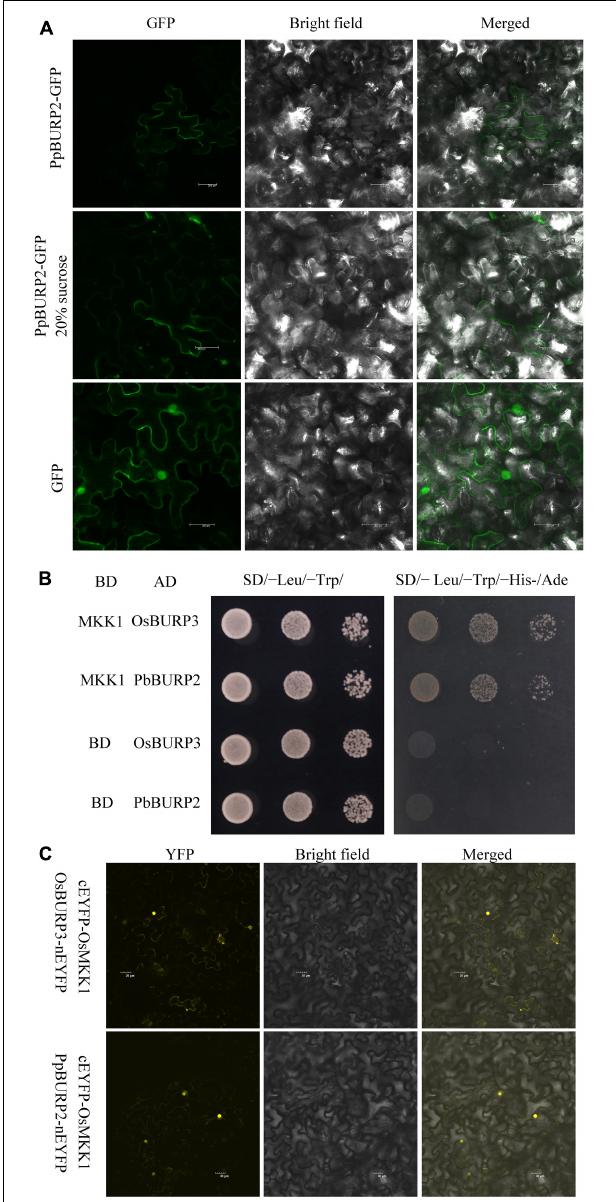
FIGURE 2 | Subcellular Location and protein interaction of PpBURP2. (A) Subcellular location green fluorescent protein (GFP) and PpBURP2-GFP fusion gene under the control of the CaMV35S promoter separately and transiently expressed in the tobacco epidermal cells. Leaves of 35S:PpBURP2-GFP tobacco before (top) and after (middle) treatment with 20% sucrose for plasmolysis, as well as 35S::GFP (bottom). The white bar represents 50 µ M. (B) BURP protein interacting with OsMKK1 using the yeast-two-hybrid method. OsMKK1 gene was cloned into pGBKT7, and OsBURP3 gene and PpBURP2 gene into pGAD-T7, respectively. All of the combinations grew on SD/-Leu/-Trp/, and SD/- Leu/-Trp/-His-/Ade medium at 30 ◦ C for 3–5 days. (C) Bimolecular fluorescence complementation (BiFC) assays in tobacco leaves indicated that the OsMKK1 interacted with PpBURP2 and OsBURP3 in vivo . The OsMKK1 gene was cloned into cEYFP vector and OsBURP3 , and PpBURP2 were cloned into nEYFP vector. Agrobacteria containing the above respective plasmids were transformed into leaves of 5-week-old N. benthamiana plants. Scale bar = 30 µ